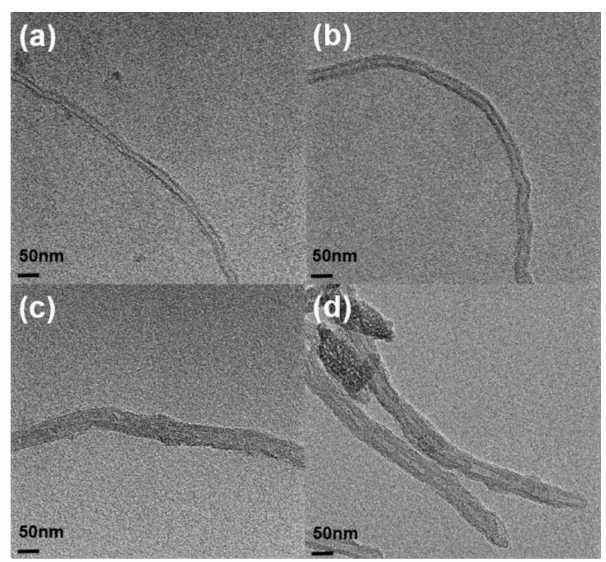
Figure 4. The TEM image of MWCNTs: ( a , b ) pristine MWCNT and ( c , d ) PMMA– g –MWCNT.